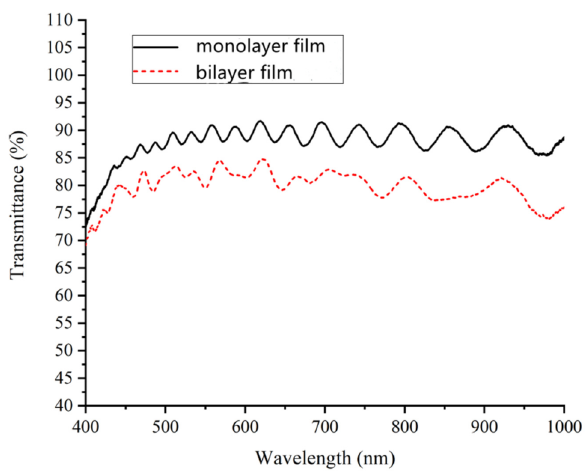
Figure 4. Transmittance of AgNW film.